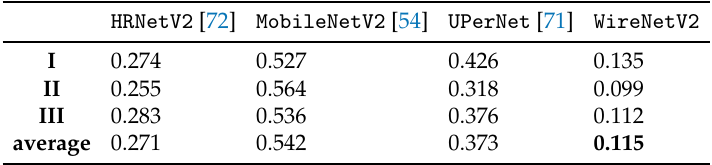
Table 5. Best-fitting errors (in meters) between the reference laser scanning point cloud and the photogrammetric point cloud computed with the different masking